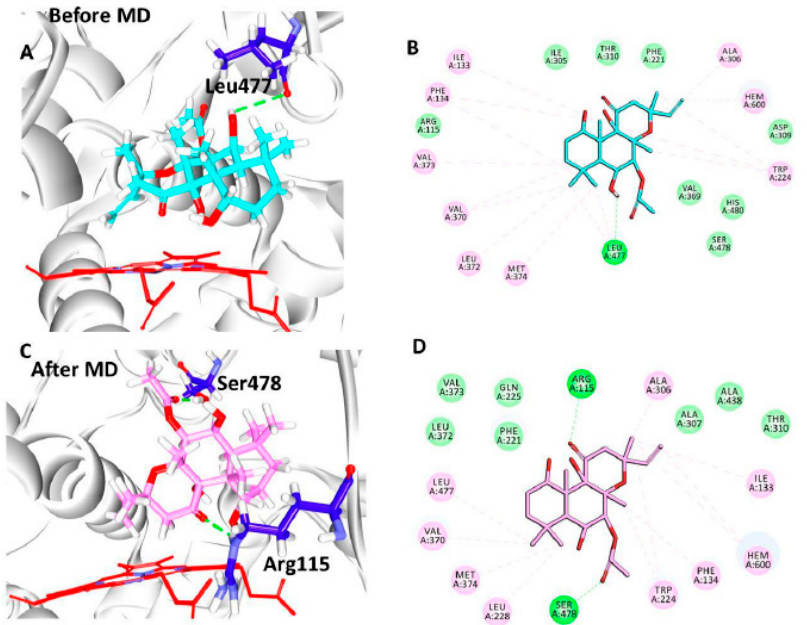
Figure 3. Intermolecular interactions between the protein and the ligand. ( A ) Only one hydrogen bond during the docking simulations. ( B ) Comprehensive intermolecular interactions. ( C ) After the MD simulations for 50 ns the ligand has formed two hydrogen bonds. ( D ) Comprehensive intermolecular interactions.